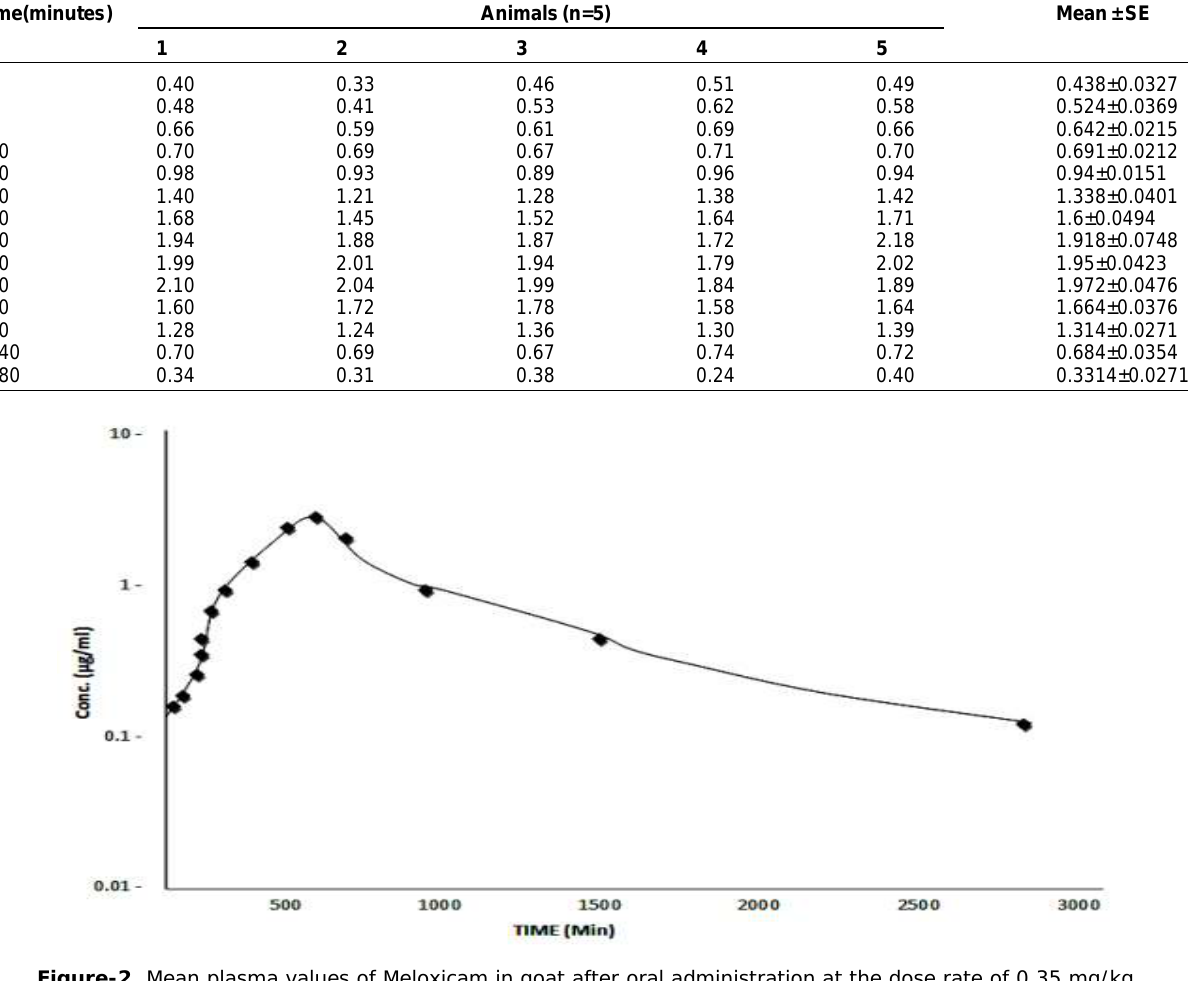
Figure-2. Mean plasma values of Meloxicam in goat after oral administration at the dose rate of 0.35 mg/kg. Table-2. Pharmacokinetics of Meloxicam after single oral administration at the dose rate of 0.35 mg/kg in goat. (n=5)